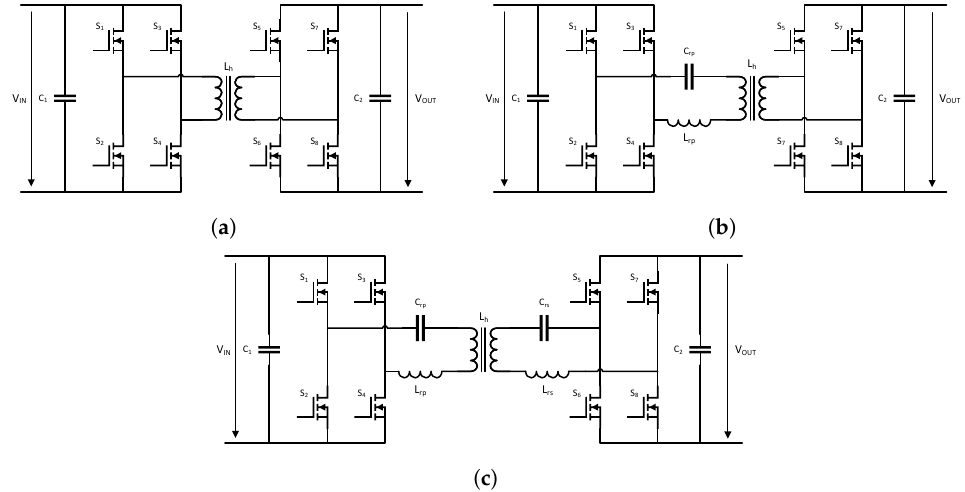
Figure 2. Comparison of converter topologies. ( a ) Conventional Dual Active Bridge, ( b ) Bidirectional LLC Resonant Converter, ( c ) Bidirectional CLLC Resonant